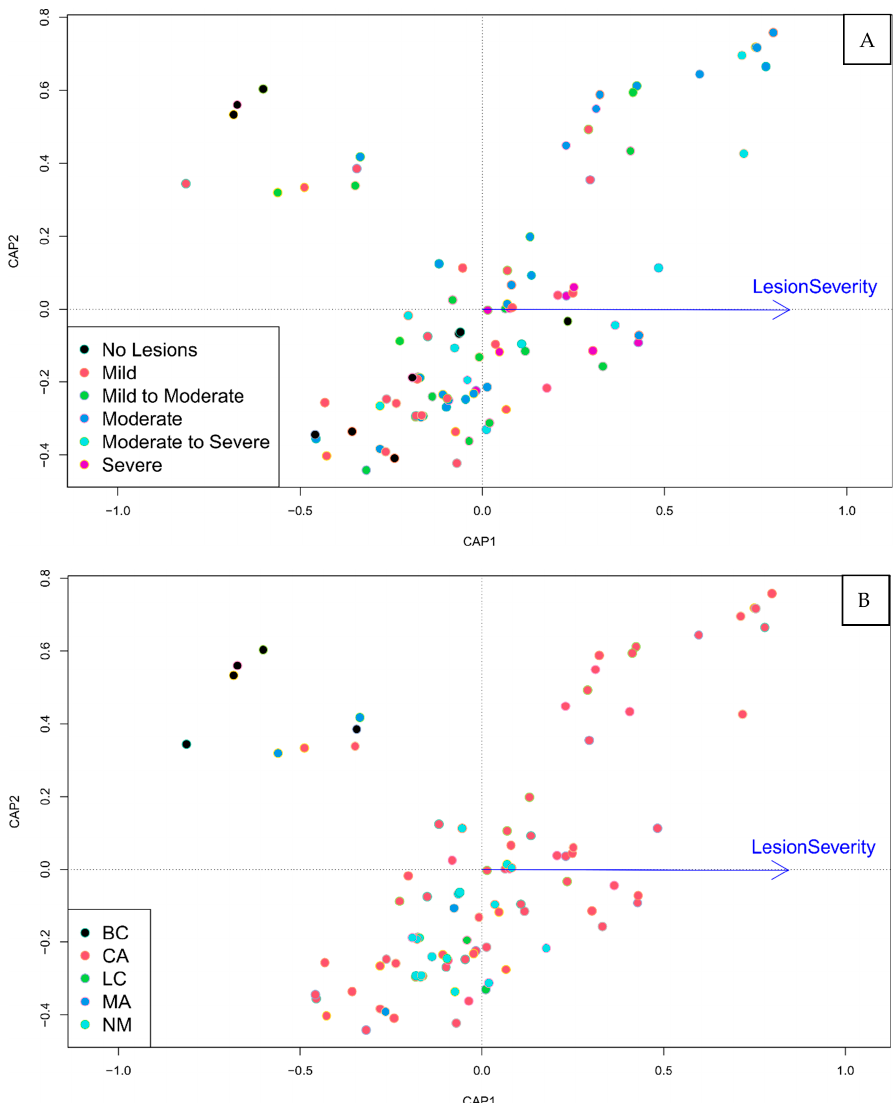
Figure 3. Disease severity and location associated with microsatellite genotype. Distance-based redundancy analysis showed significant association between disease severity and microsatellite variation. ( A )—samples colored based on clinic location. ( B )—samples colored by disease severity. Locations included in study are California (CA); New Mexico (NM); Boulder County, CO (BC); Larimer County, CO (LC); and Massachusetts (MA). Position on the plot for each sample depicts genetic differentiation. Arrow = disease severity increases direction of